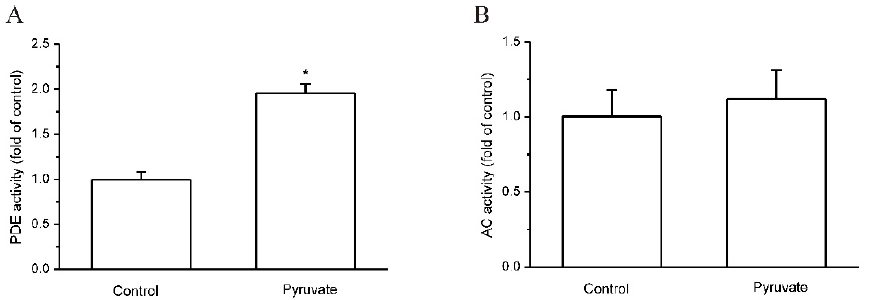
Figure 3. Pyruvate activated PDE in HepG2 cells. ( A ): Pyruvate significantly increased phos- phodiesterase (PDE) activities in HepG2 cells (* p < 0.05 vs. control, n = 5). ( B ): Pyruvate had no effect on adenylyl cyclase (AC) activities in HepG2 cells ( n = 5).